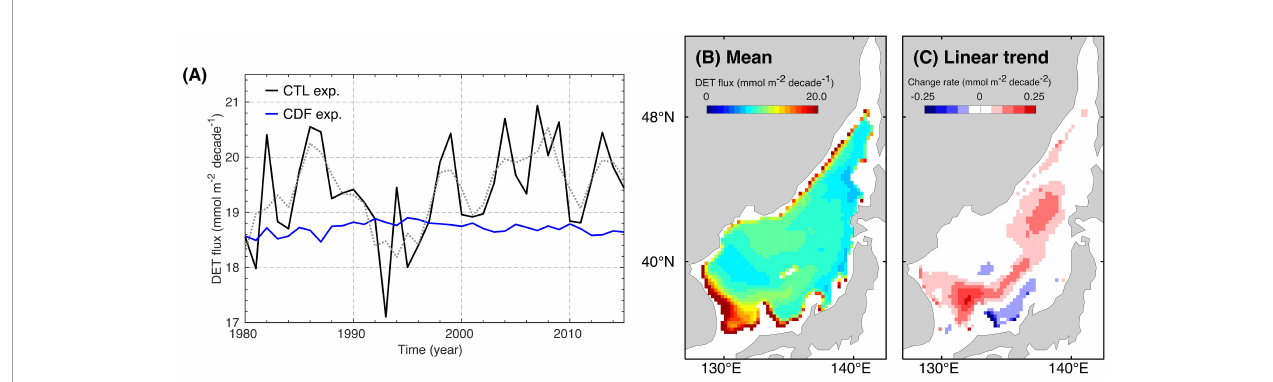
FIGURE 8 | (A) Long-term variation in the detritus (DET) fl ux into the lower layers averaged in the East/Japan Sea, which is determined by the incoming fl ux through 516 m depth and the outgoing fl ux of the sedimentation at the bottom. The black and blue solid lines indicate the results of the control (CTL) and constant detritus fl ux (CDF) experiments, respectively. The gray dotted line represents the 3-year moving average of the detritus fl ux simulated by the CTL experiment. (B) Spatial distribution of the mean detritus fl ux and (C) spatial pattern of the linear trend in the detritus fl ux of the CTL